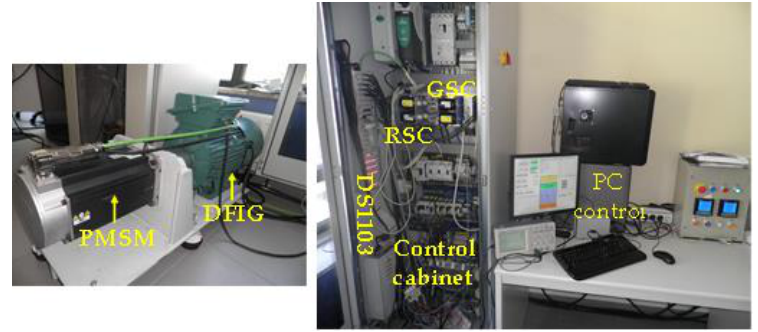
Figure 12. DFIG platform used to test the proposed control strategies. Table 1. Leroy Somer DFIM main parameters